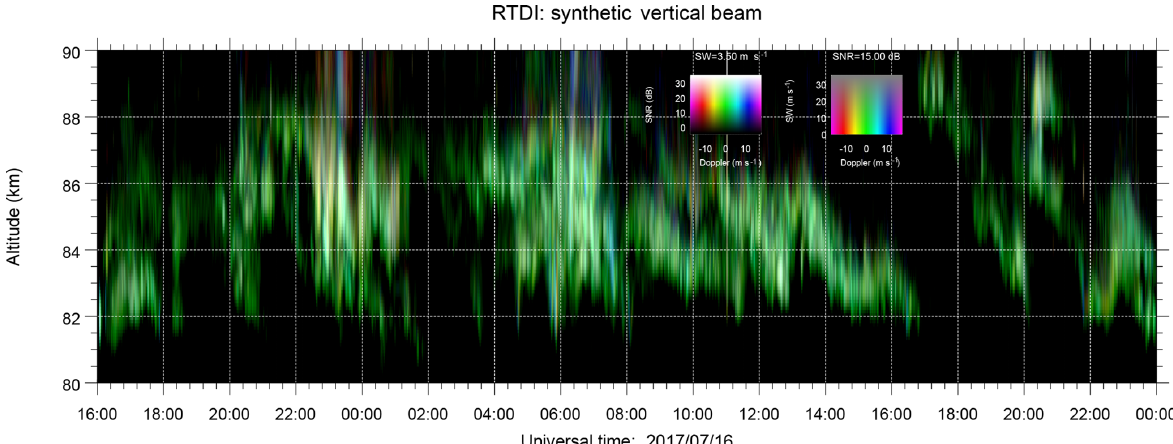
Figure 2. A 24-bit image of a range–time Doppler intensity (RTDI) plot of PMSEs using MIMO, with time diversity conducted on 16 and 17 July 2017. The signal intensity is represented as lightness, Doppler information as hue, and spectral width as saturation. The legend on the left represents the SNR vs. Doppler color map for a saturation of 90%. The legend on the right represents the spectral width vs. Doppler for a lightness of 50%. Note that only the signal corresponding to the narrow region in the illuminated area is shown.